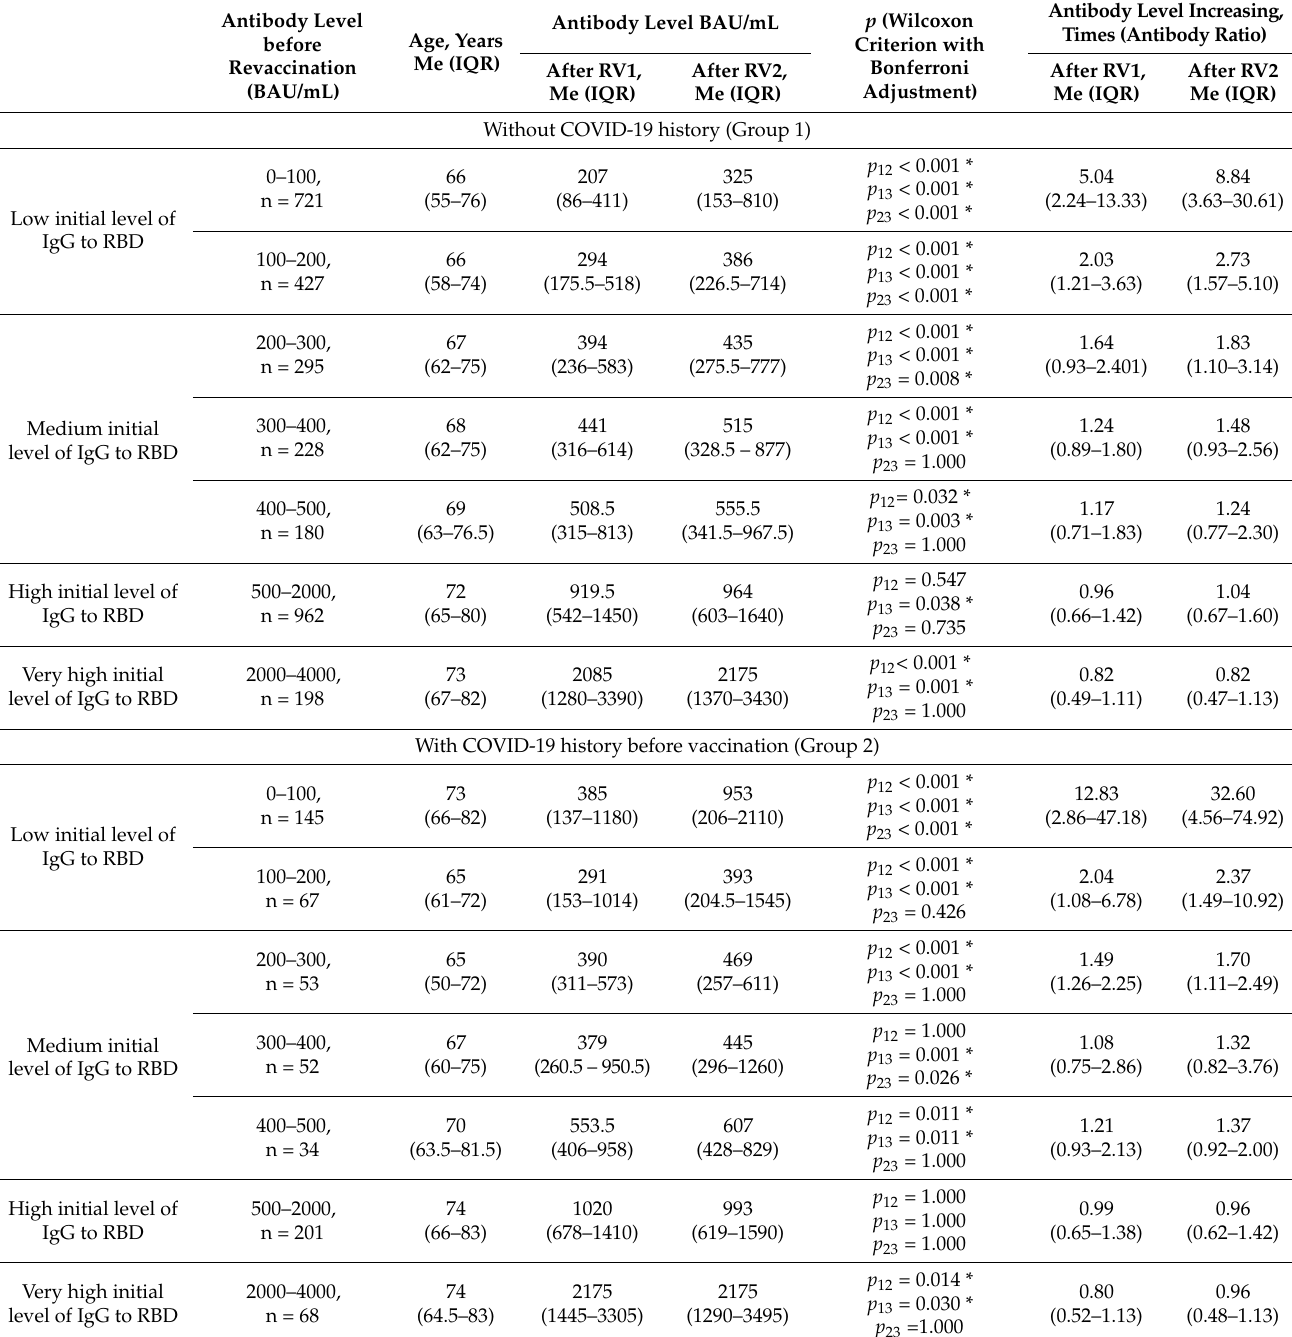
Table 3. Immunological effectiveness of revaccination with Sputnik V depending on initial antibodies level before